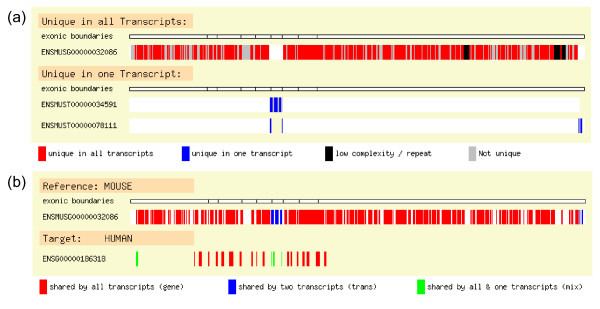
Graphical representation of unique genomic regions. (a) The graphical display for the unique regions within a genome depicts the full-length sequences, without common introns, as white rectangles with the unique regions in red for genes (top) and blue for individual transcripts (bottom). Repeats or low complexity regions are highlighted in black and those redundant in grey. (b) For the unique regions shared across genomes, the two levels of the display correspond to all the unique regions of the gene in the reference organism and those matched by the target organism. The colour-coded scheme for the reference is the same as in (a). For the target, the shared unique positions are placed relative to those matched with the reference and the colours represent all the possible combinations that can be found between the shared sequences, as explained in the main text.